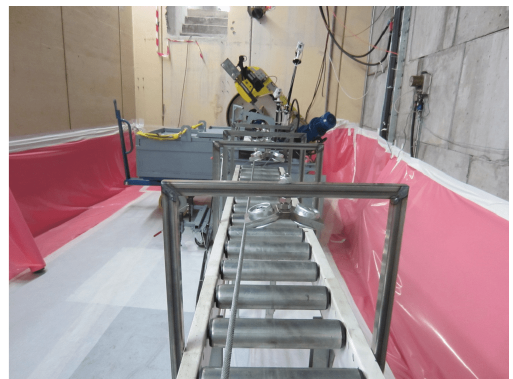
FIG. 17. Tooling for the extraction of the original dump core and beam pipe out of the dump cavity. In the foreground, the support structure with rollers and the winch cable. In the background, the remotely operated saw and the lead-shielded